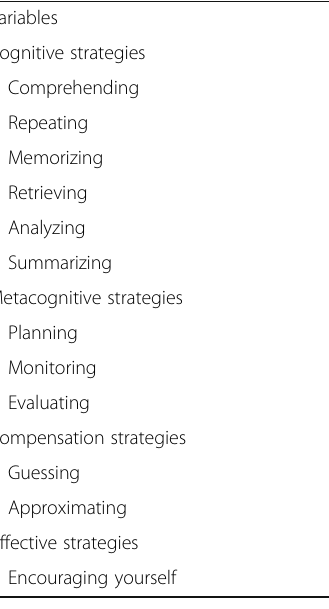
Table 2 Coding theme of the think-aloud